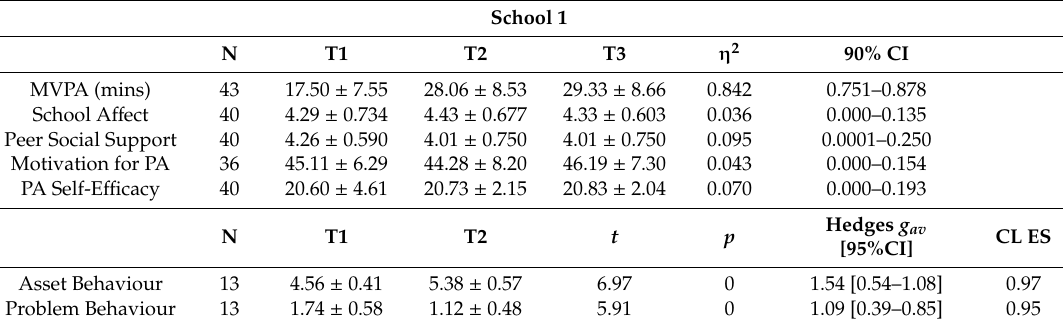
Table 4. School 1—mean scores and change over time for outcome variables.